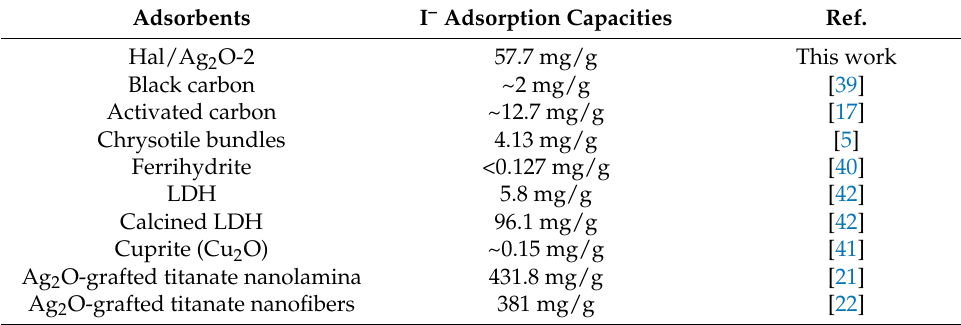
Table 2. Comparison of adsorption capacities of different adsorbents for I –